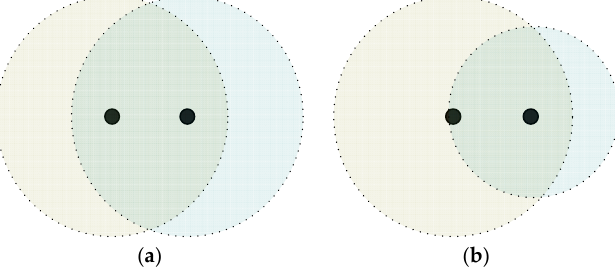
Figure 2. Different Disc Models: ( a ) Homogeneous Disc Model; ( b ) Heterogeneous Disc Model.